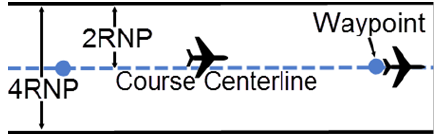
Figure 1. Plan view for RNP segment width.